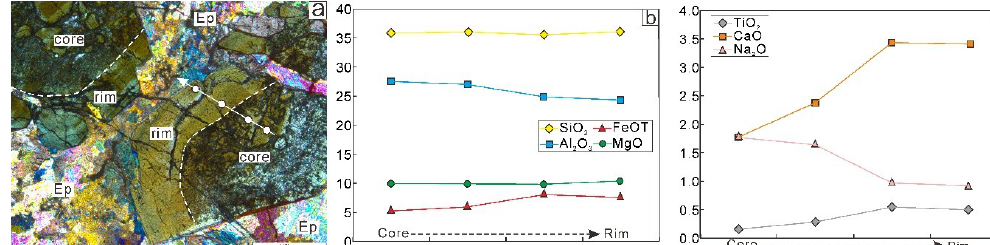
Figure 8. Major chemical element compositional profiles for the Yamansu zoned tourmaline. ( a ) Growth zonation and test points of tourmaline; ( b , c ) Variations of elements in compositional profile of tourmaline.